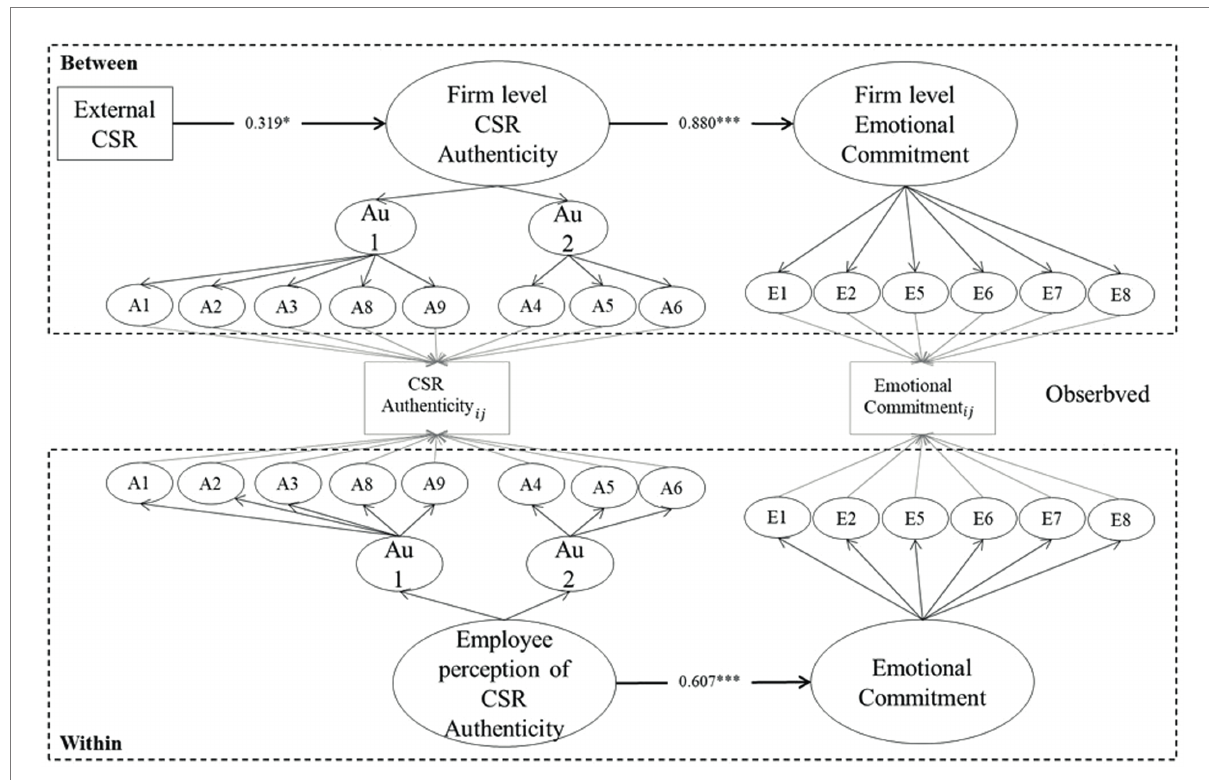
FIGURE 2 Multilevel SEM test of hypothesized relationships (full mediation). Factor loadings are not displayed Estimates reported are standardized values. We control for industry, listed firms, firm age, unionization, sales, advertisement intensity, and intensity at the firm level, and gender, age, employment, marriage, job level, education, job, union, and tenure at the individual level (not shown) in this model.